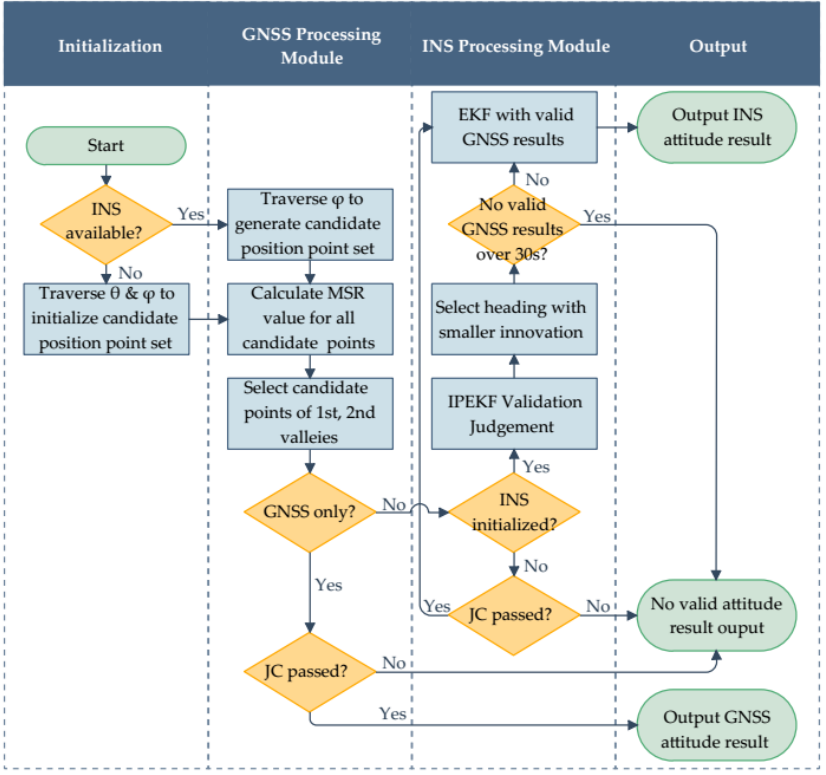
Figure 7. Flow chart of the MSR-based GNSS/INS integrated attitude determination system.